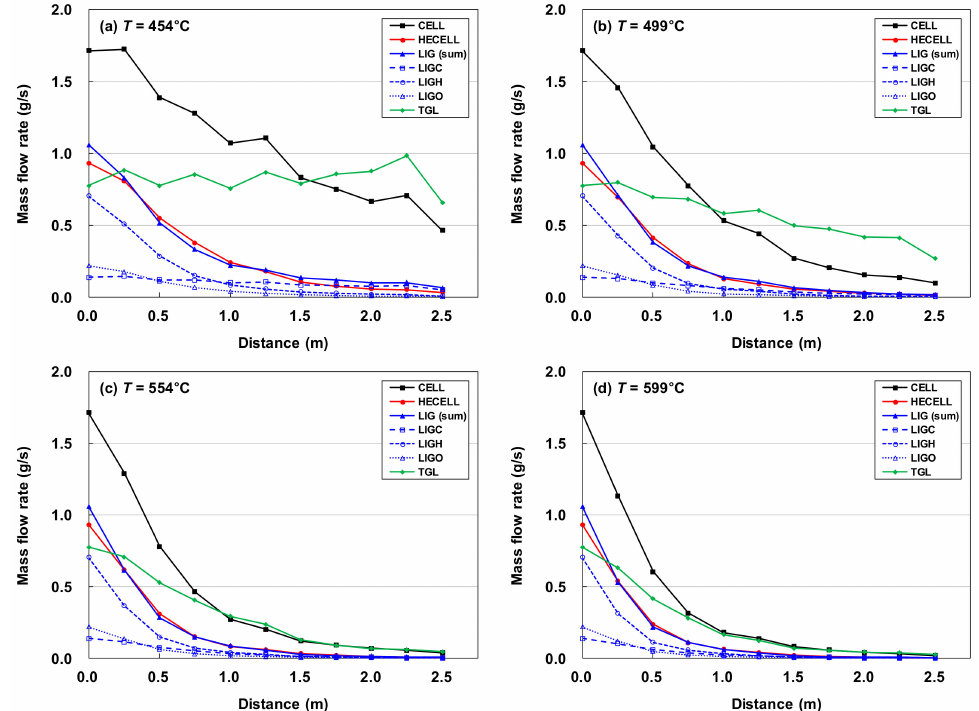
Figure 11. Mass flow rate of biomass components along the distance from the top of the